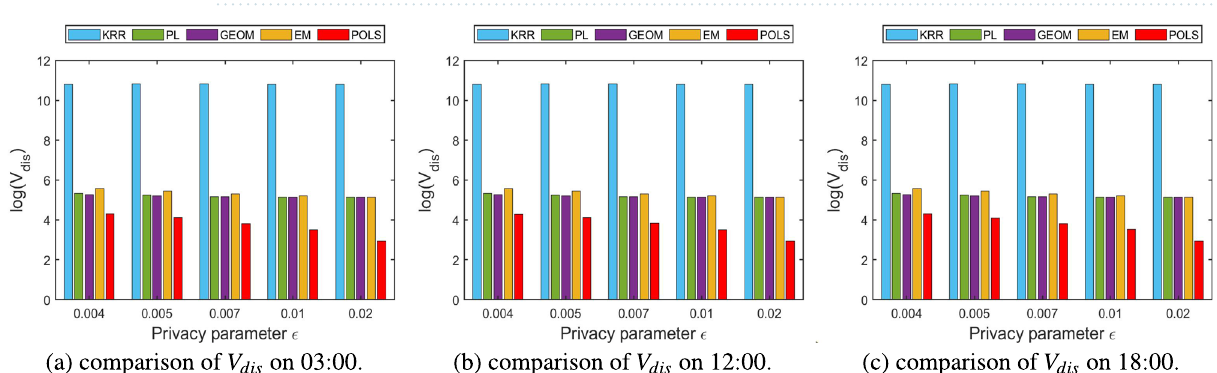
Figure 7. Comparison of M dis among different perturbation algorithms.